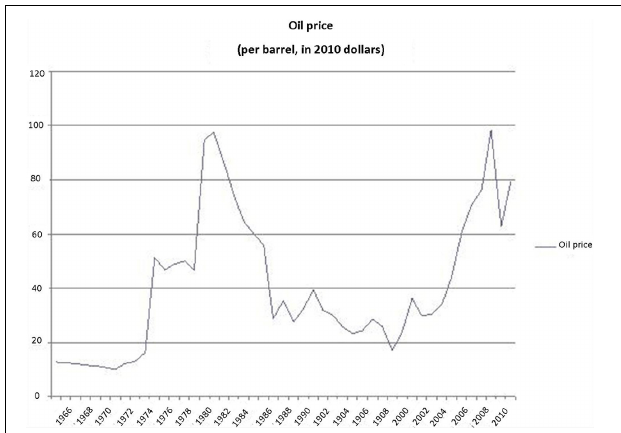
FIGURE 3 | Oil Prices Per Barrel from 1966 to 2010 (sources: BP Statistical Review of World Energy, 2011 5 ; Crude Oil Spot Prices, US Energy Information